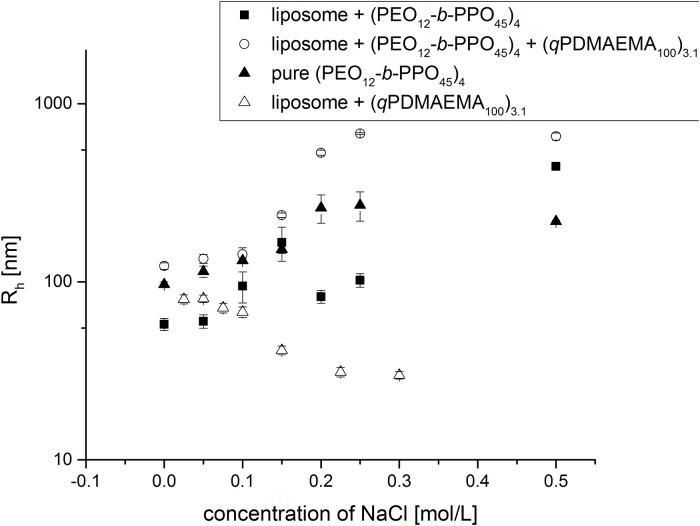
Salt stability enhancement.Hydrodynamic radii of the (PEO12-b-PPO45)4, the liposome/(PEO12-b-PPO45)4 complexes, the liposome/(qPDMAEMA100)3.1/(PEO12-b-PPO45)4 complexes and the liposome/(qPDMAEMA100)3.1complexes at different NaCl concentrations. The lipid concentration for each sample is 6.37 x 10−5 mol/L. Where relevant, the concentration of the positive charges of (qPDMAEMA100)3.1 was held constant at 1.9 10−6 mol/L (which correspond to a charge ratio Z = 0.3, the liposomes are in excess). The concentration of (PEO12-b-PPO45) is 7.5 10−7 mol/L. Tris Buffer pH = 7, 20°C.